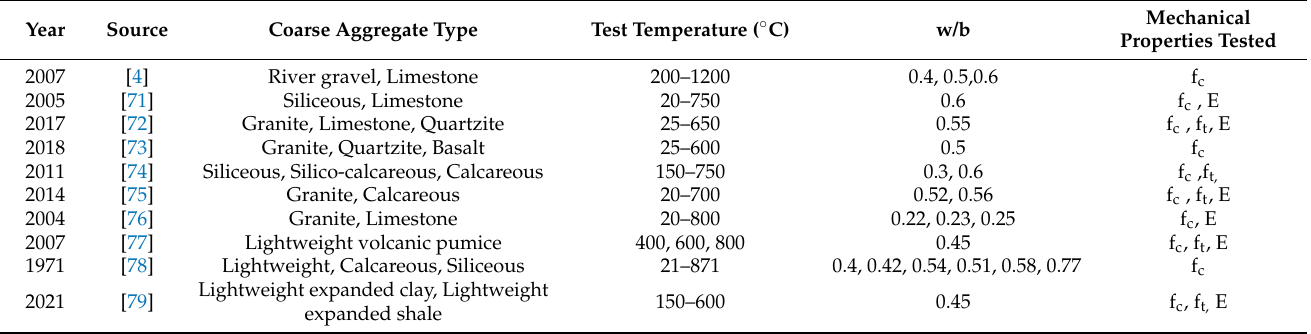
Table 3. Summary of research on the influence of different aggregate types on the mechanical properties of concrete after high exposure to high